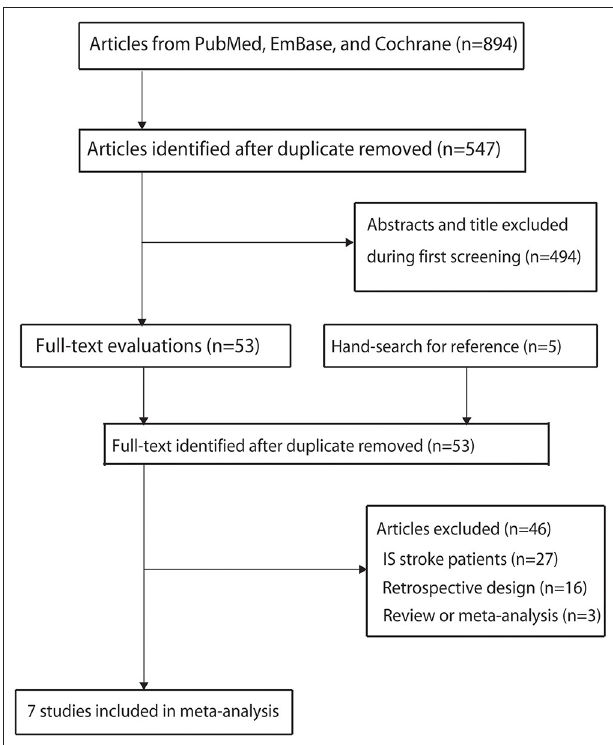
FIGURE 1 | Details regarding the literature search and study selection